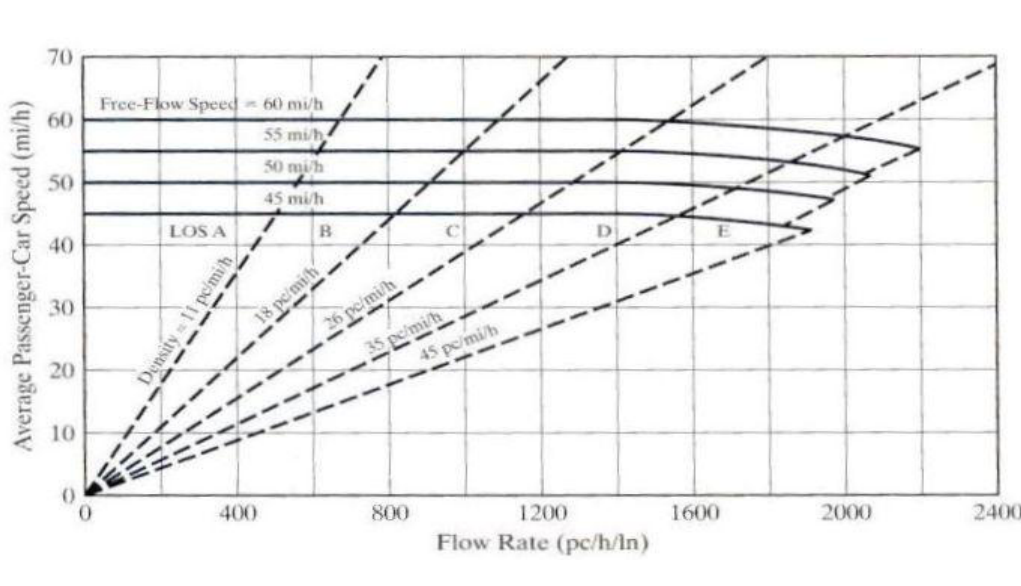
Figure 3. Speed-Flow Curves for multilane highway sections (The Highway Capacity Manual, 2000, Exhibit 21-3,